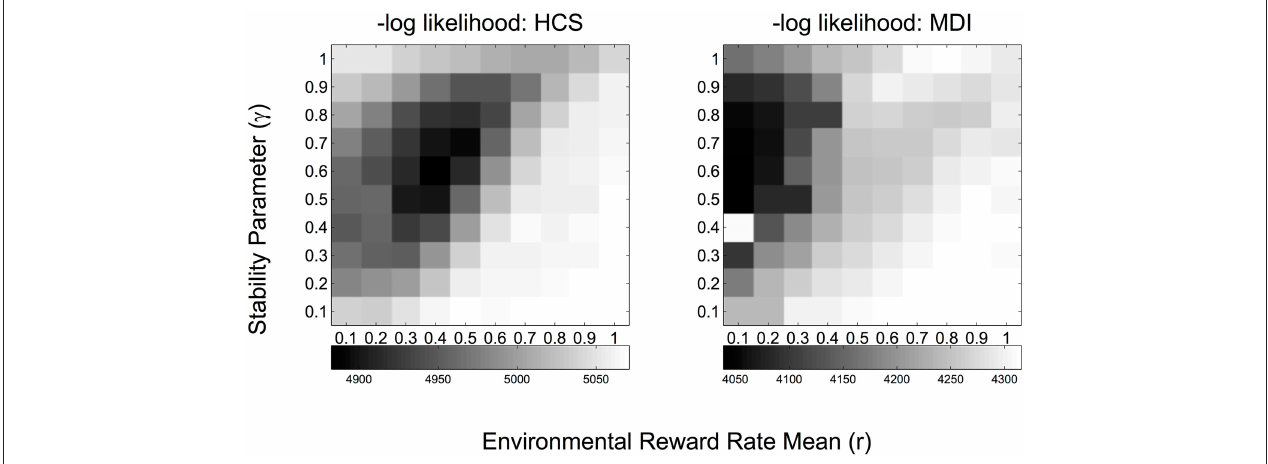
FIGURE 3 | -Log likelihood grayscale plots for each pair of DBM parameter values ( γ , r ) fitted at the group level (MDI, methamphetamine dependent individuals; HCS, healthy comparison subjects). Values represent − 2*log likelihood, where the likelihood is marginalized over uncertainty associated with the decision policy utilized by each subject and the parameter setting of the policy. Darker color indicates lower log likelihood, thus better fit.